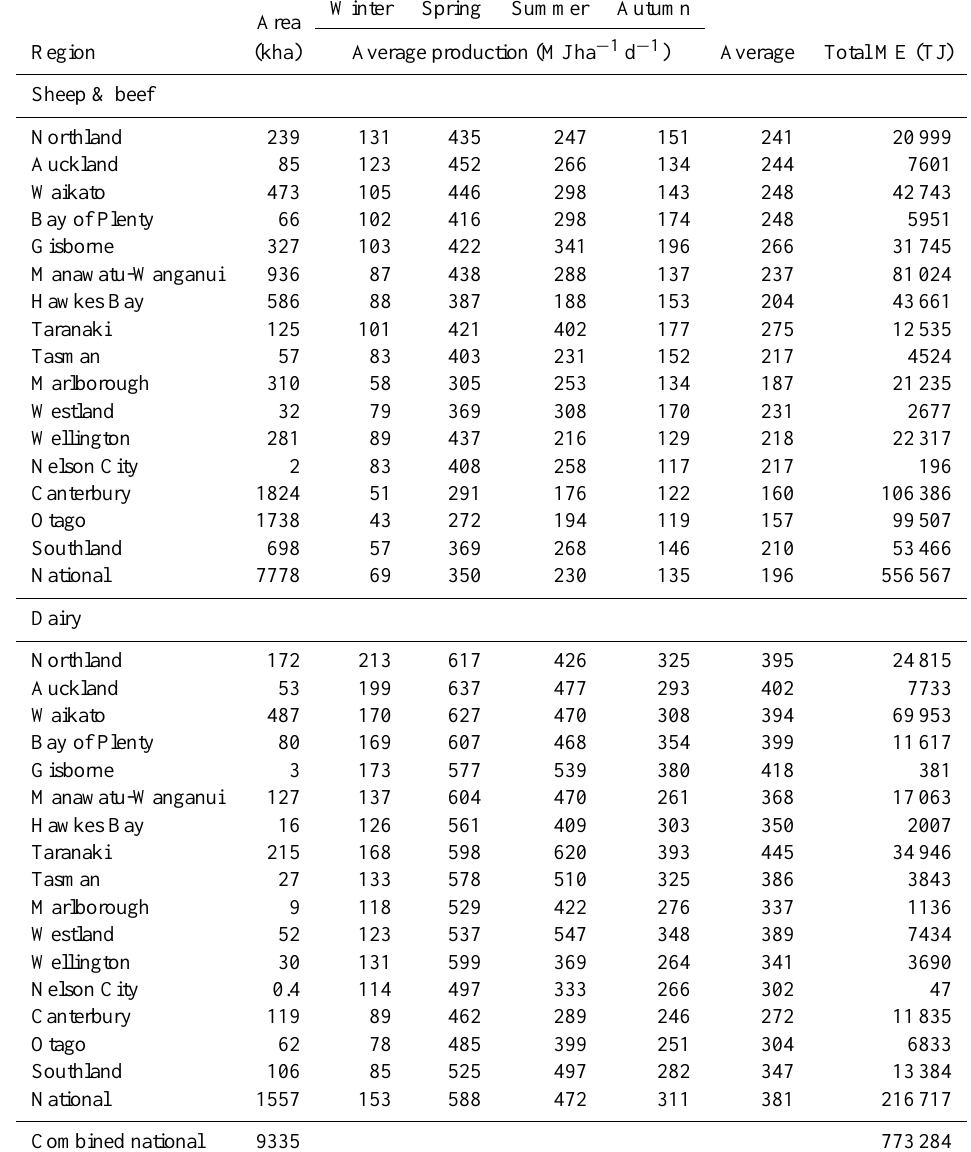
Table B2. Baseline average production by region and season over the period 1997–2011 in units of metabolisable energy. Winter Spring Summer Autumn Area Region (kha) Sheep & beef